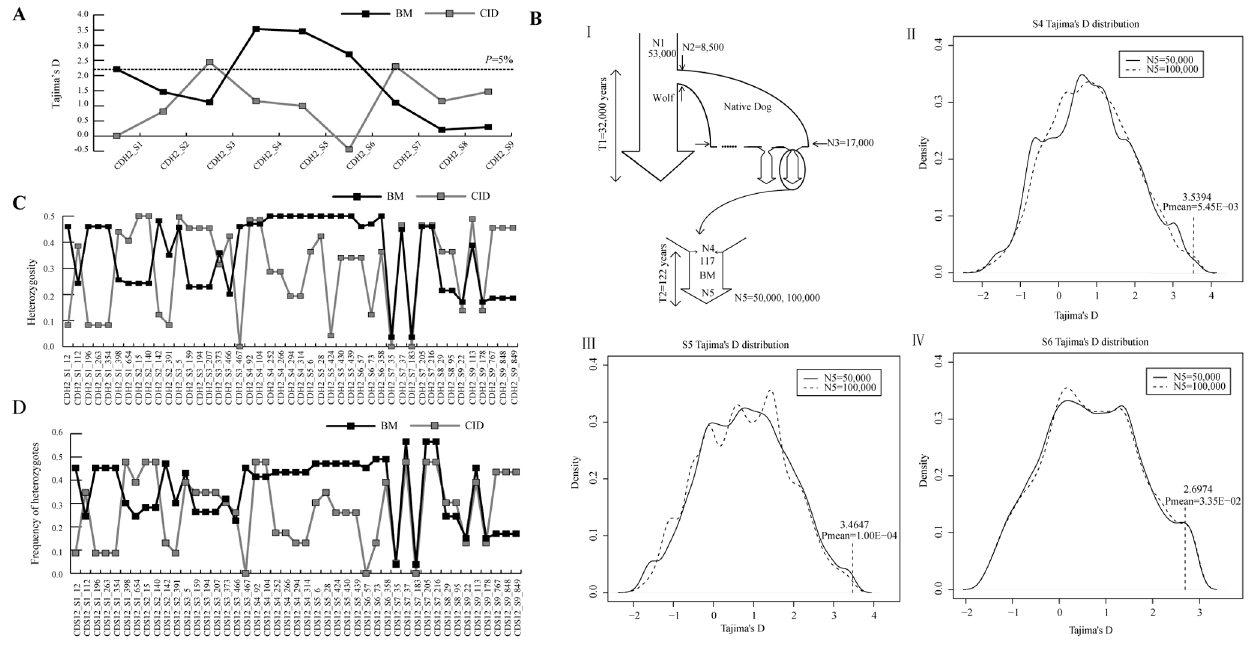
Figure 2. The distribution of three population genetic statistics and the information of coalescent simulations. (A) Distribution of Tajima’s D values for the 9 segments of the CDH2 gene region in the BM and CID populations. (B) Standard coalescent simulations under a neutral model for the genealogy of the BM. Part I is the genealogy of BM and parts II-IV are standard coalescent simulations for segments S4, S5, S6, respectively, under different values for N5 (50,000 and 100,000) in the BM population. P mean is the mean of the P values for the Tajima D test. (C) SNP heterozygosity distribution in the CDH2 gene region in the BM and CID populations. (D) Frequency distribution of heterozygotes for each SNP in the BM and CID populations. doi:10.1371/journal.pone.0110075.g002 PLOS ONE |